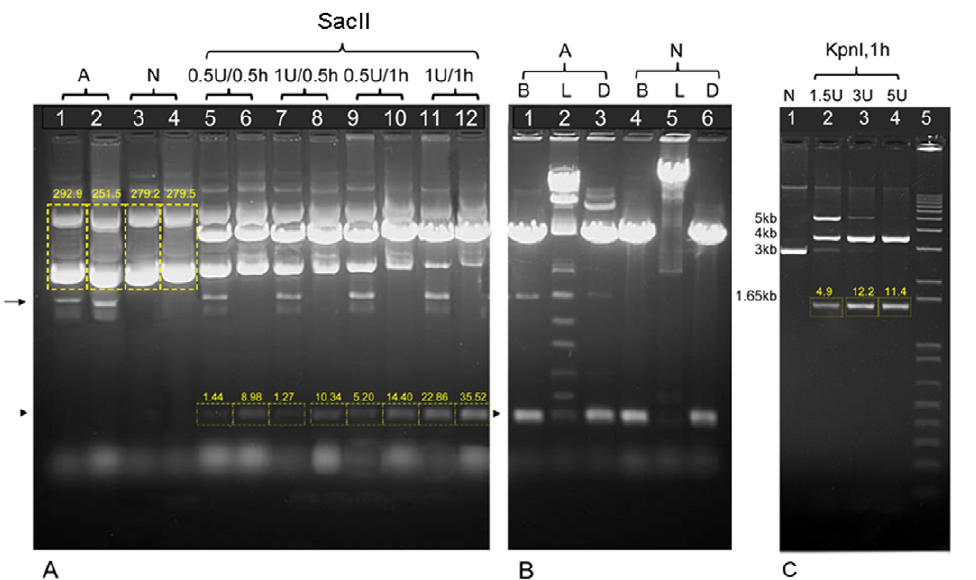
Figure 2. NID-extracted DNA of both high and low copy number plasmids perform well in common downstream applications. ( A ) Restriction endonuclease digestion of the high copy number pLTM330 plasmid containing 2 SacI sites separated by approximately 400 bp. extracted by either alkali or NIDs. XL1-Blue cells harboring pLTM330 in 1.5 ml LB cultures were used for isolation. After alcohol precipitation, alkali DNA pellets were rinsed with 0.5 ml ethanol and dissolved in 40 m l TE buffer, but NID DNA pellets were directly dissolved in 40 m l TE buffer. 9 m l aliquots of native DNA of two independently isolated samples were loaded in lanes 1, 2 (alkali, A) and lanes 3, 4 (NID, N). Densitometry analysis is reported for lanes 1–4. 9 m l DNA was also used for every DNA restriction and ligation reaction in 11 m l total volume. Restriction digests with the indicated amount of restriction enzyme for the indicated length of incubation at 37 u C are shown in lanes 5, 7, 9, 11 for the alkali method and lanes 6, 8, 10, 12 for the NID protocol. Arrow indicates ‘‘irreversibly denatured’’ DNA [1,25,29]. Arrowhead indicates the 400 bp band, and densitometry analysis of this band is reported for lanes 5–12. DNA restriction reactions were carried out in NEB1 buffer. ( B ) Plasmid samples digested using 2u SacI for 1 hour (lanes 1,4) were ligated using 0.1 Weiss unit T4 DNA ligase at 15 u C for 30 minutes (lanes 2,5). Ligation products were then re-digested using 2u SacI for 1 hour (lanes 3,6). DNA restriction and ligation reactions were carried out in NEB1 buffer, but 1 mM ATP was added for the ligation reactions. Arrowhead indicates 400 bp band. B= cut sample. L= ligated sample. D= re-cut sample. Lane 2 shows the intermediate ligation products of the 400 bp DNA fragment in lane 1. ( C ) DH5 a cells harboring the low copy number plasmid pEL04, containing 2 KpnI sites separated by approximately 1.5 Kb. NID plasmid isolation was performed as reported in Materials and Methods, except that lysozyme concentration in the extraction buffer was 50 m g/ml. 9 m l DNA in 11 m l total reaction volume were used for digestions. Lane 1: native DNA (N). Lane 2: DNA digestion by 1.5u KpnI. Lane 3: 3u KpnI. Lane 4: 5u KpnI. The incubation times were 1 hour. Lane 5: 1 Kb Plus DNA Ladder (Invitrogen). Densitometry analysis of the expected 1.5 Kb digestion product is reported in lanes 2–4.